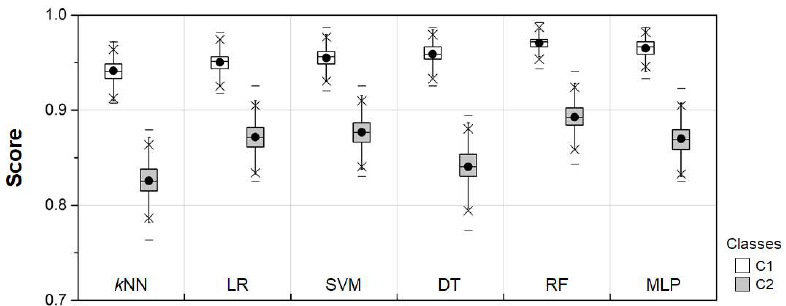
Figure 5. The comparison of MCS results for basic precipitation classes (C1) and further refinement of snow classes (C2). The feature set F5 was used for this analysis.